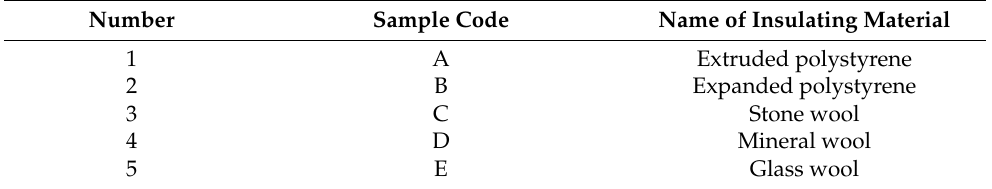
Table 2. Combination of insulating materials.